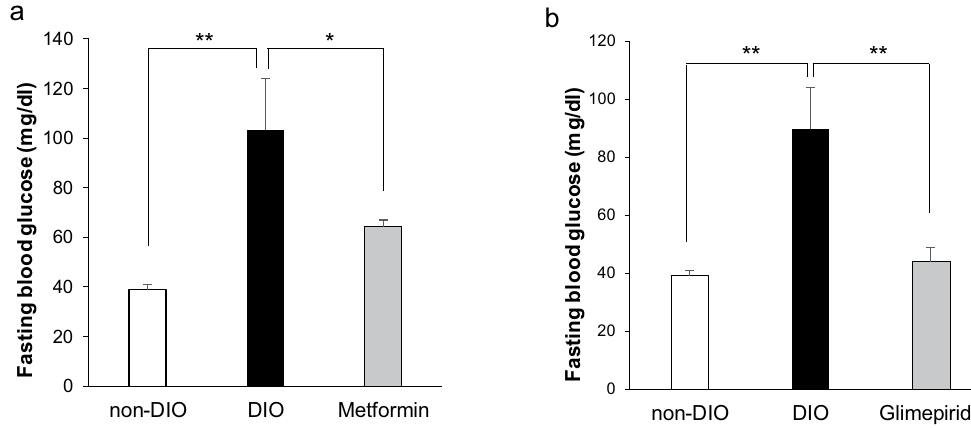
Figure 4. The effects of anti-diabetic drugs on DIO zebrafish. ( a ) Effect of metformin (20 μ M) on blood glucose levels of DIO zebrafish after 7 days’ treatment. ( b ) Effect of glimepiride (100 μ M) on blood glucose levels of DIO zebrafish after 24 h treatment. n = 5–10. Values are means ± SE. * P < 0.05, ** P < 0.01 vs. the non-DIO group.